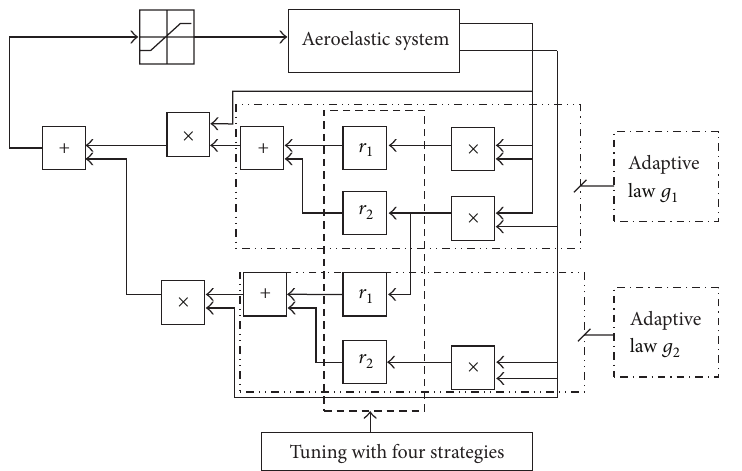
Figure 12: Block diagram of the adaptive stall flutter control